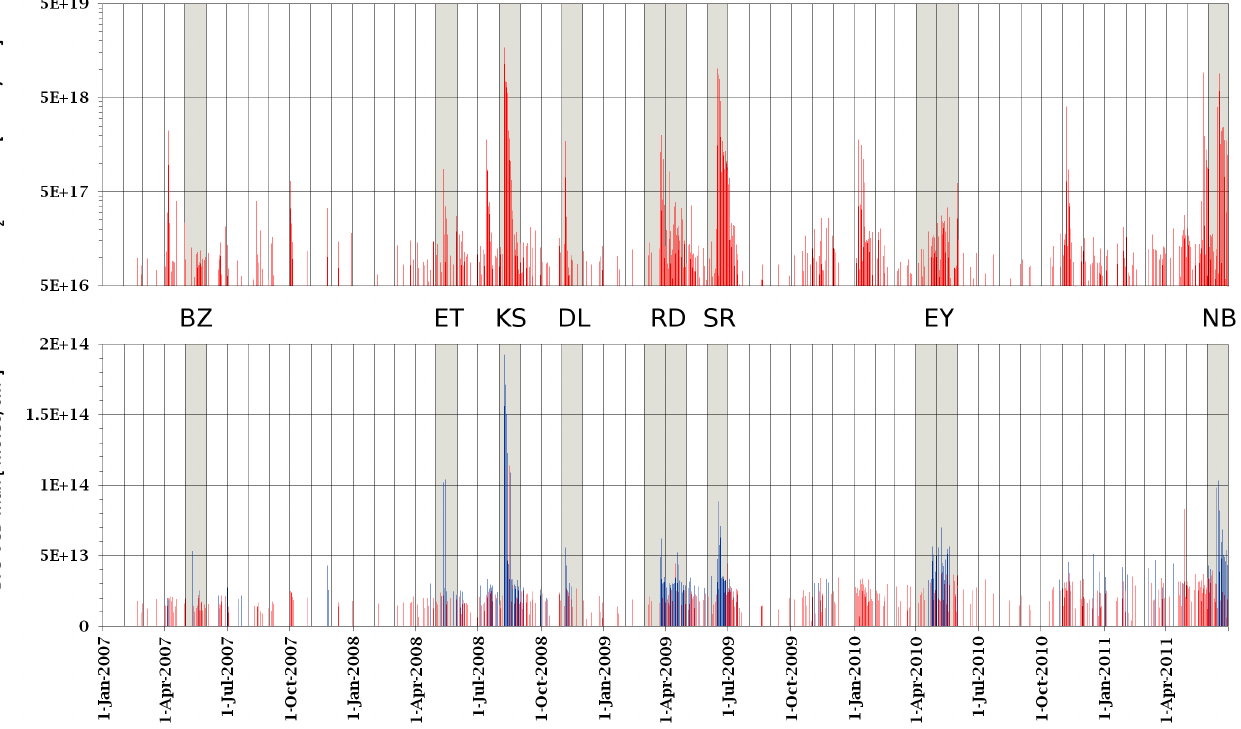
Fig. 5. Time-series of maximum GOME-2 SO 2 and BrO VCDs ∗ (geometrical AMF and background corrected) within all individual vol- canic plumes, captured by the automatic plume detection algorithm between January 2007–June 2011. For several SO 2 plume events, the maximum BrO VCDs ∗ are significantly elevated at the same time (please note the logarithmic scale for SO 2 ). This is, in particular, the case for the eruptions during the highlighted periods (BZ – Bezymianny, ET – Etna, KS – Kasatochi, DL – Dalaffilla, RD – Redoubt, EY – Eyjafjallaj¨okull, NB – Nabro). The BrO VCDs that were larger than two times the associated fit error are highlighted in blue. Table 2. Examples for the abundance of volcanic BrO that are presented in Sect.